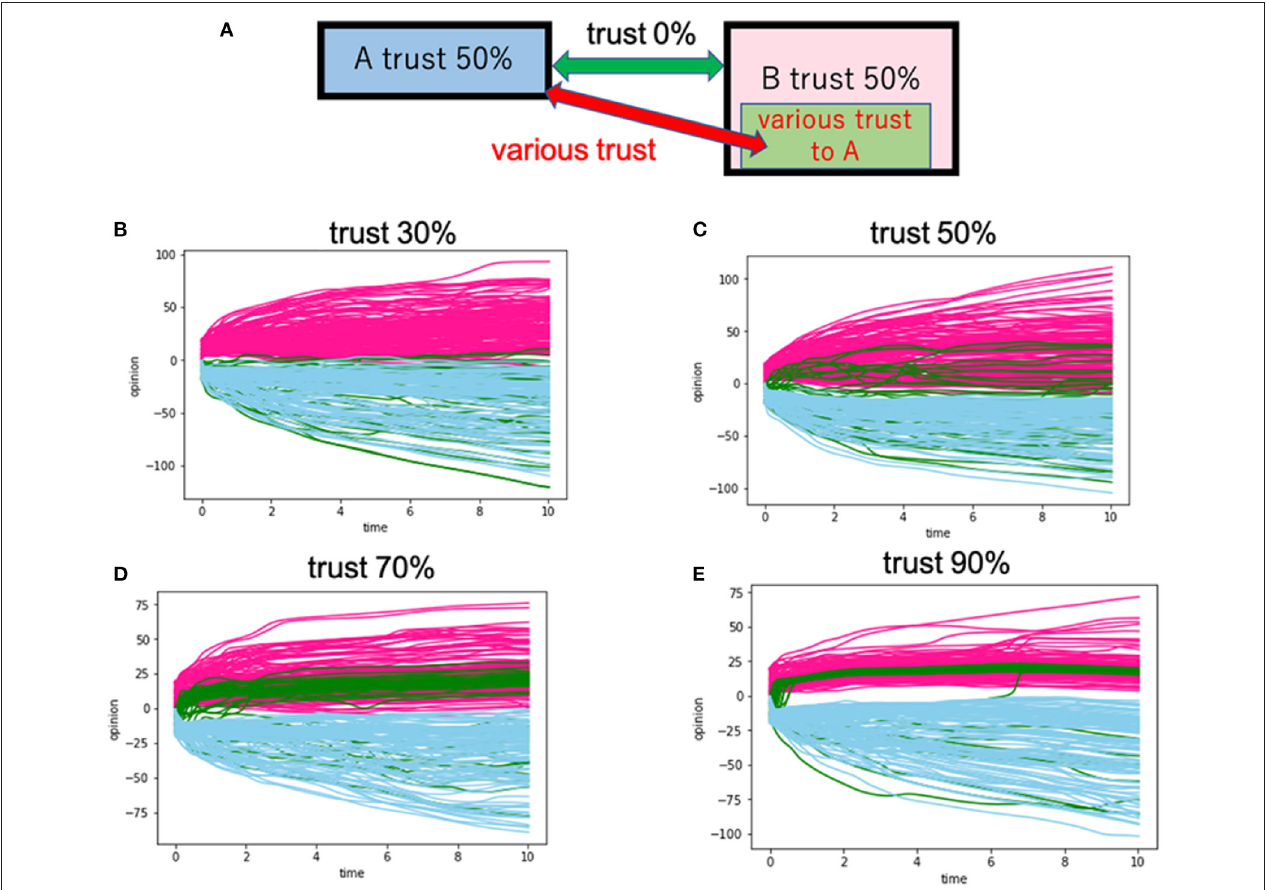
FIGURE 8 | Cases in which no intergroup trust exists between group A and group B. The intragroup trusts for group A and group B are fixed at 50%. However, 50 people in group B (B-1) have intergroup trust toward group A. (A) Is the model’s schematic view. In (B–E) , there are various intergroup trusts between the B-1 and group A. For instance, the trust 70% means that 70% of the trust ( D ij ) exists between the B-1 and group A. The red lines correspond to the opinion trajectories of group A. The blue lines are those of group B except for the B-1 subgroup. The green lines are the opinion trajectories of B-1.